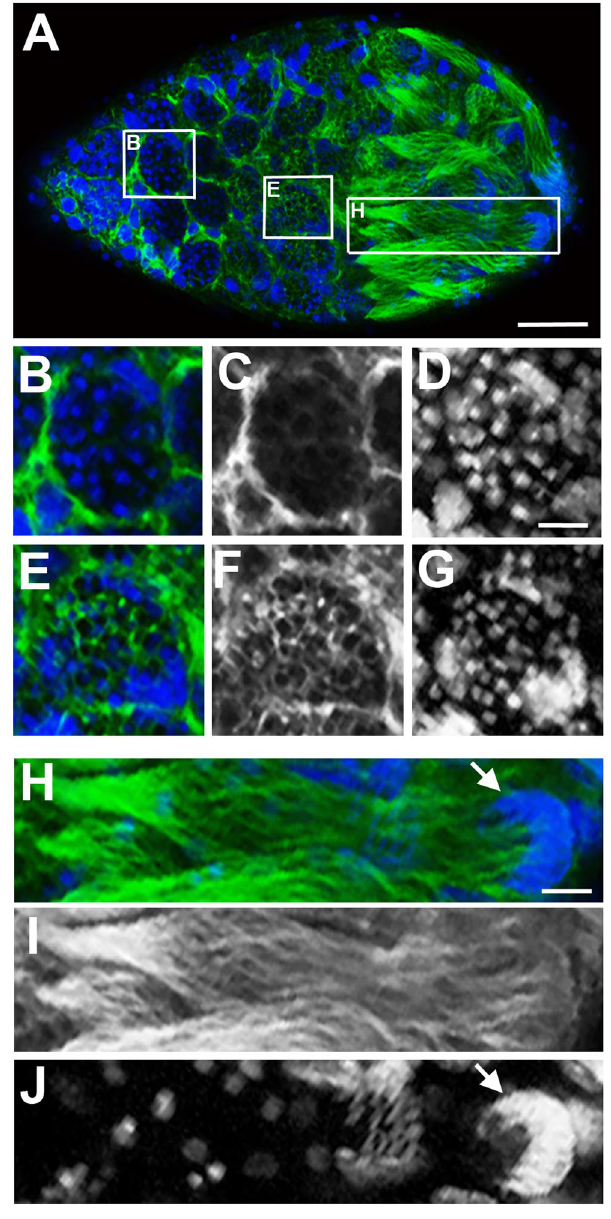
Figure 3. Sperm tail formation in the N . vitripennis testis. Regions in the testis of yellow body-red eye pupa devoid of nuclei ( A ) are filled with extending sperm tails (microtubules are green; DNA is blue). ( B – D ) Microtubules are enriched outside but not inside of cysts at the apical end of the testis. ( B ) is a merge; ( C ) is microtubules in greyscale; ( D ) DNA in greyscale. ( E – G ) Germ cells in a more posterior-located cyst have entered into spermiogenesis, as indicated by their condensed nuclei. The microtubules have begun to become enriched within each cell ( E is a merge; F is microtubules in greyscale; G is DNA in greyscale). ( H – J ) A bundle of spermatids with elongating tails, whose ends coalesce into a ‘cone’ like structure. ( H ) is a merge of microtubules in green and DNA in blue. The arrow in ( H , J ) indicates the elongating nuclei that are tightly organized into a cup. ( I ) Microtubules is in greyscale; ( J ) DNA is in greyscale. Scale bar equals 50 μ m in ( A ), 10 μ m in ( D ), and 15 μ m in ( H